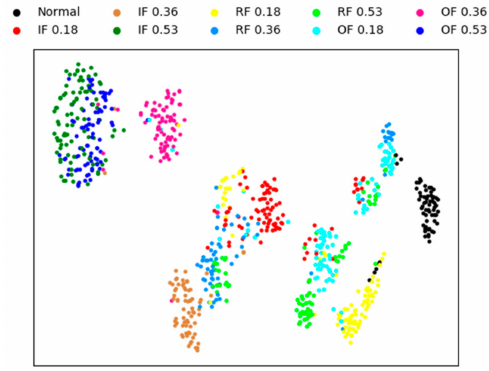
Figure 8. Visualization of sparse AE for the learned